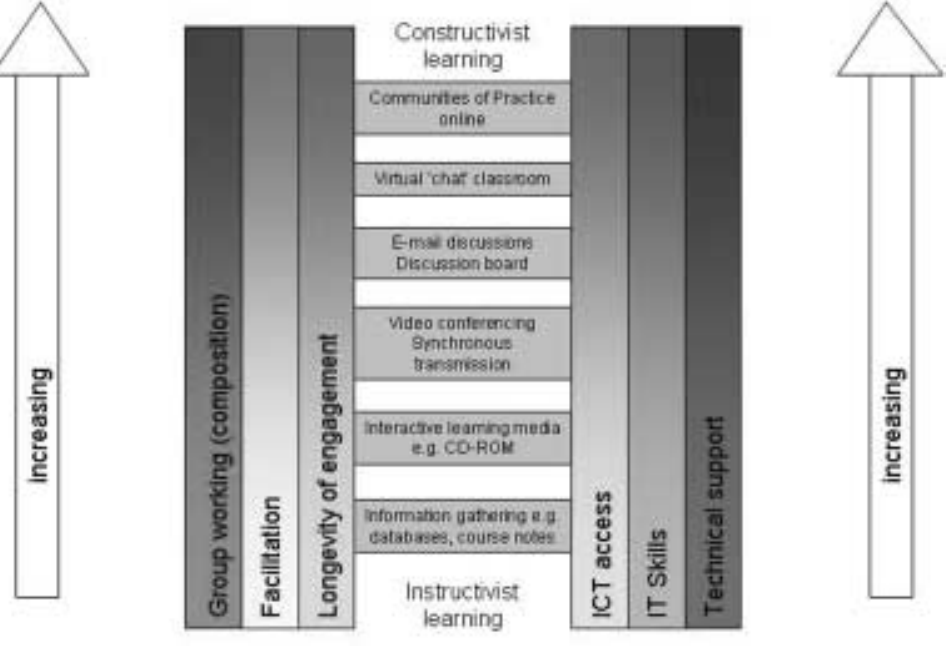
Figure 1. A conceptual model of online learning: the e-learning